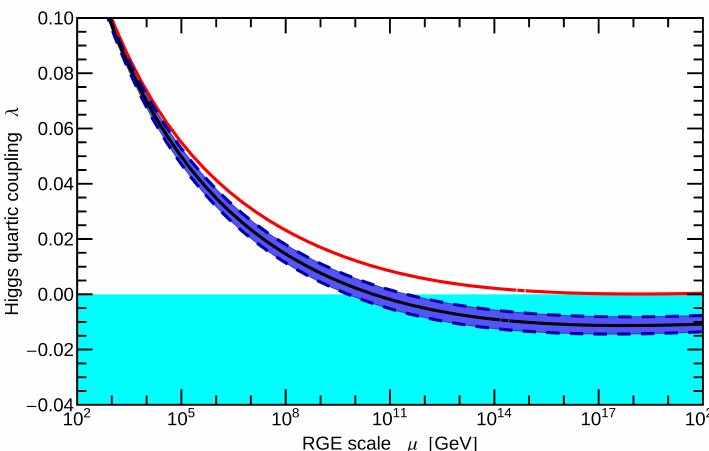
Figure 2. The renormalization group (RG) evolution of the Higgs selfcoupling λ for M t (cid:39) 173.34 GeV and α s = 0.1184 given by ± 3 σ . Blue lines present metastability for current experimental data, red (thick) line corresponds to the stability of the EW